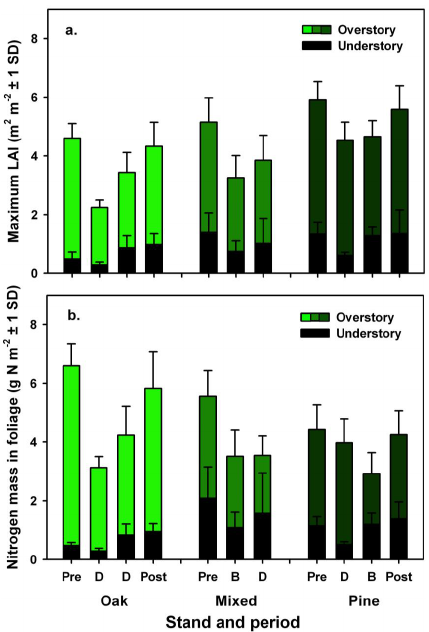
Figure 1. (a) Maximum leaf area index (LAI; m 2 m − 2 ground area Figure 1. a) Maximum leaf area index (LAI; m 2 m -2 ground area ± 1 standard deviation) and b) 851 ± 1 standard deviation) and (b) maximum nitrogen content in fo- maximum nitrogen content in foliage (g N m -2 ground area ± 1 standard deviation) during the 852 liage (gNm − 2 ground area ± 1 standard deviation) during the sum- summer at the oak, mixed, and pine stands from 2004 to 2009. Data are shown for understory, 853 mer at the oak, mixed, and pine stands from 2004 to 2009. Data overstory and total LAI and N content. Pre = pre-disturbance, D = defoliation by Gypsy moth, B 854 are shown for understory, overstory and total LAI and N content. = burned in prescribed fire, Post = post-disturbance. Pre-disturbance at the oak stand was 2004- 855 Pre = pre-disturbance, D = defoliation by Gypsy moth, B = 2006, complete defoliation by gypsy moth occurred in 2007, partial defoliation by gypsy moth 856